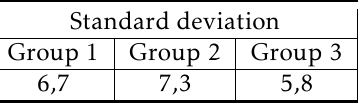
Table 1. Gradient between repetitions.